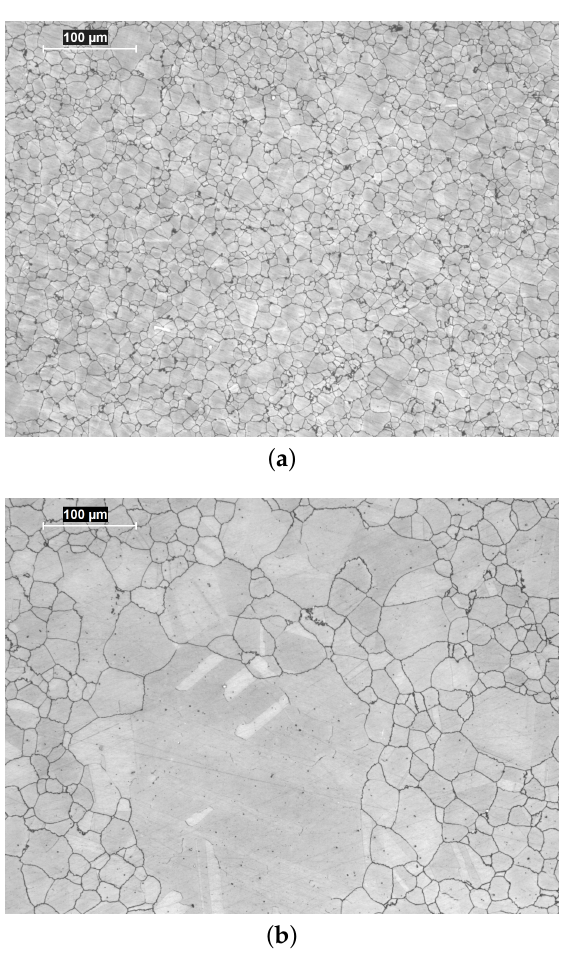
Figure 4. Pictures showing the microstructure of specimens extracted from Bar A ( a ) and Bar B ( b ).